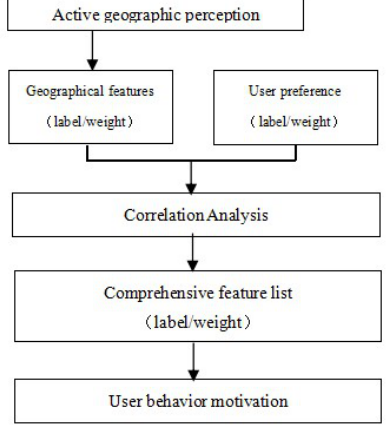
Figure 5 User motivation inference